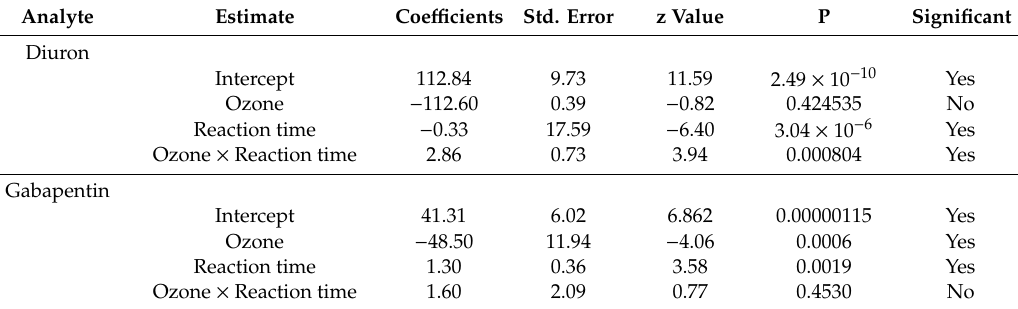
Table 8. Gaussian distribution analysis considering parameters interactions.